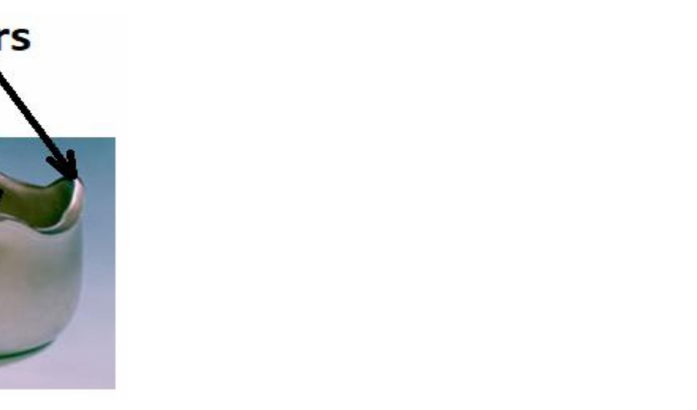
Figure 1. Earing effect after drawing a cylindrical billet from an anisotropic aluminum